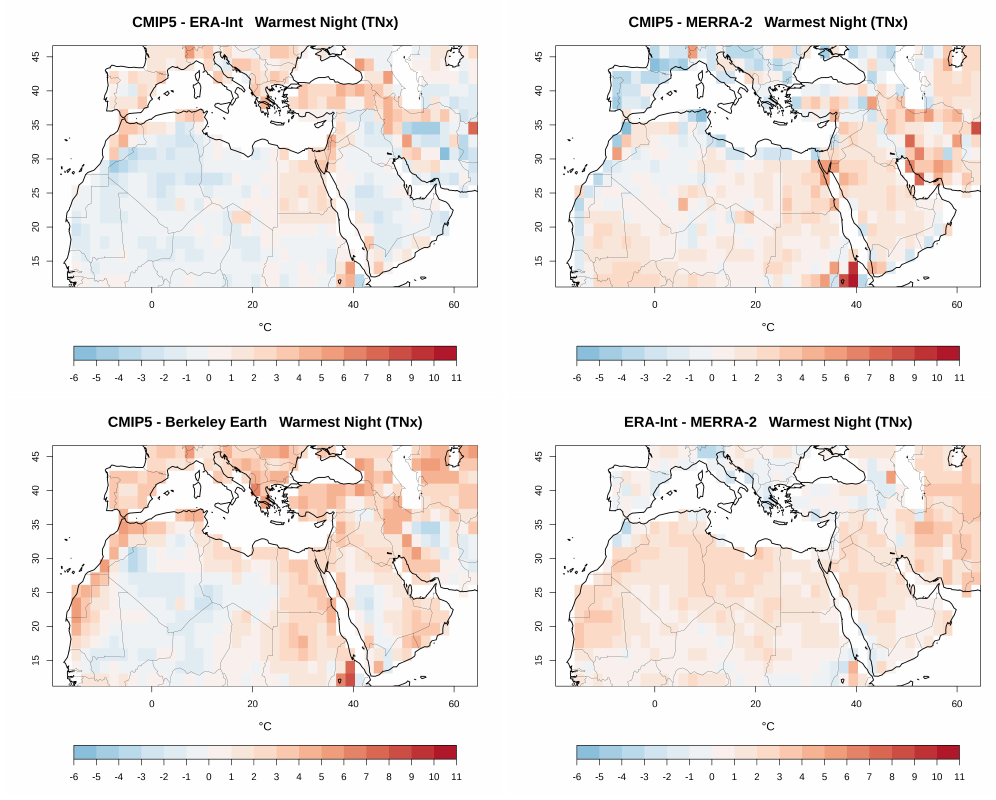
Figure A2. Same as Figure A1 but for the Warmest Night (TNx).